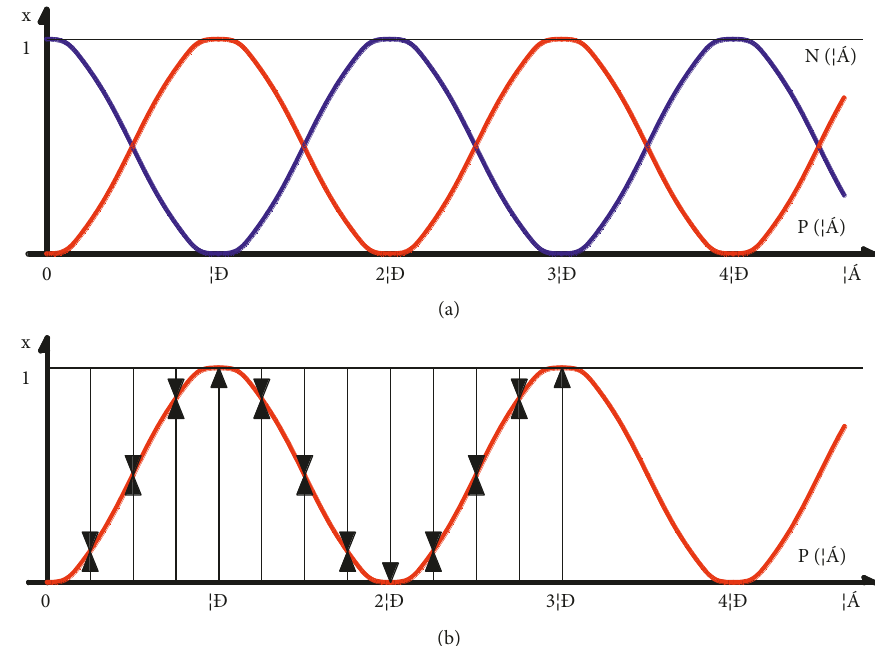
Figure 6: Yang and Yin values in the form of the triangle function. (a) Yangzhi and Yinzhi; (b) Yangzhi result.